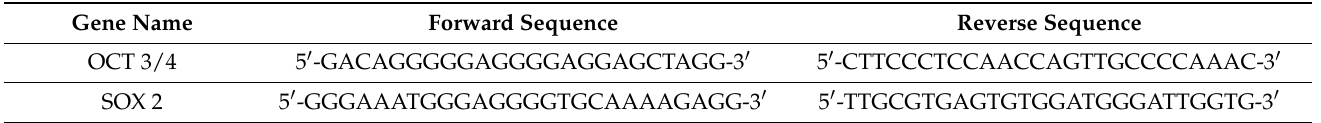
Table 1. OCT 3/4 and SOX 2 primer